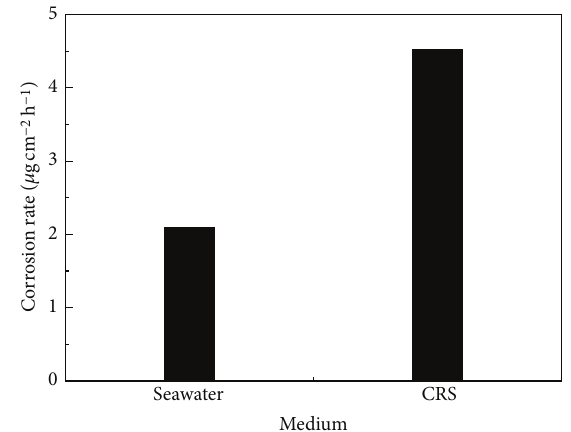
Figure 3: Corrosion rate of galvanized steel immersed at 0.1MPa hydrostatic pressure and 293 K in seawater and CRS solution after 30